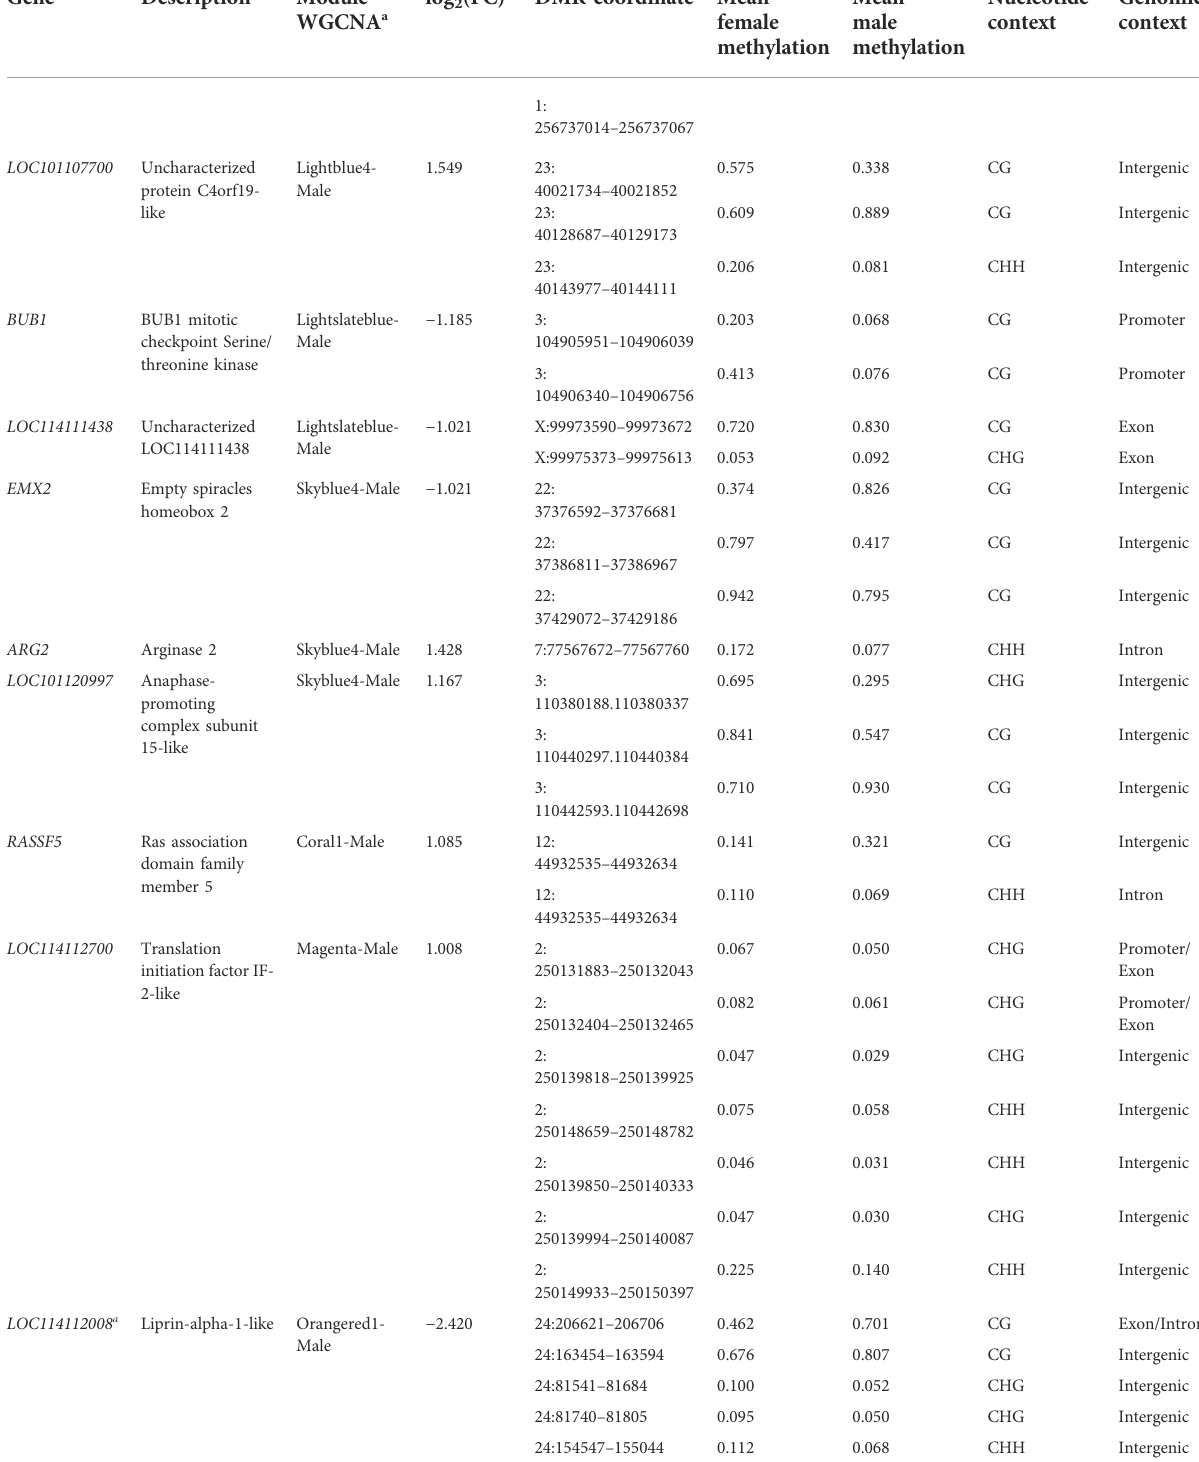
TABLE 3 ( Continued ) Sex discriminant genes identi fi ed by the multiblock (s)PLS-DA* discriminant analysis. These genes were allocated in differentially coexpressed modulesfromtheweightedcorrelationnetworkanalysis(WGCNA)*,andweresigni fi cantlycorrelated withthefatpercentageindifferent adipose deposits (Renal, Pelvic, Renal and Pelvic, Leg subcutaneous, and Leg intramuscular). For each gene is indicated: their symbol, the description, the coexpression module, the fold change (base 2 logarithm), the DMR location in the reference genome (chromosome: coordinates), the proportion of methylation in females and males, and the sequence and genomic